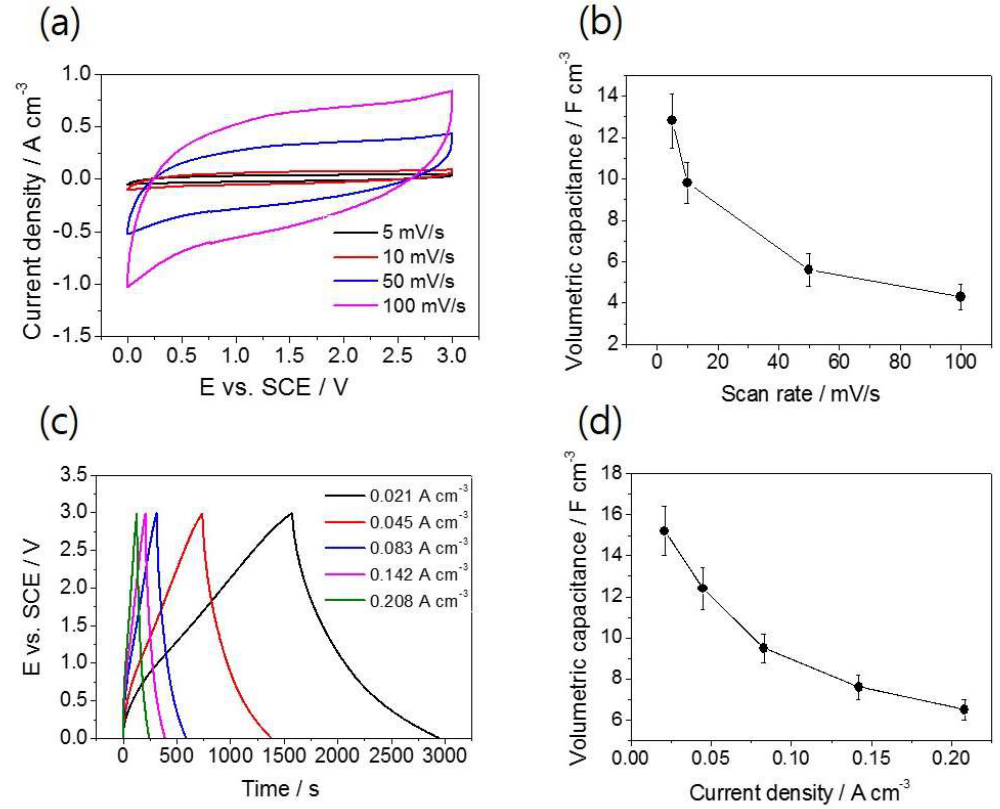
Figure 5. Electrochemical measurements of the as-prepared stretchable supercapacitor. ( a ) Cyclic voltammograms of the supepcapacitor at a scan rate from 0.005 V s − 1 to 0.1 V s − 1 ; ( b ) Volumetric capacitance as a function of scan rate; ( c ) Galvanostatic discharge curves at various current densities; ( d ) Volumetric capacitance as a function of current density.